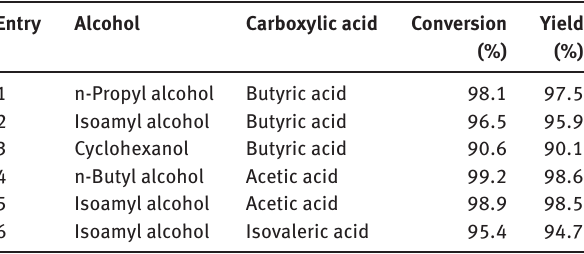
Table 5: Esterification of various alcohols with carboxylic acids over [GlyH] H PW O catalyst. a 1.0 2.0 12 40